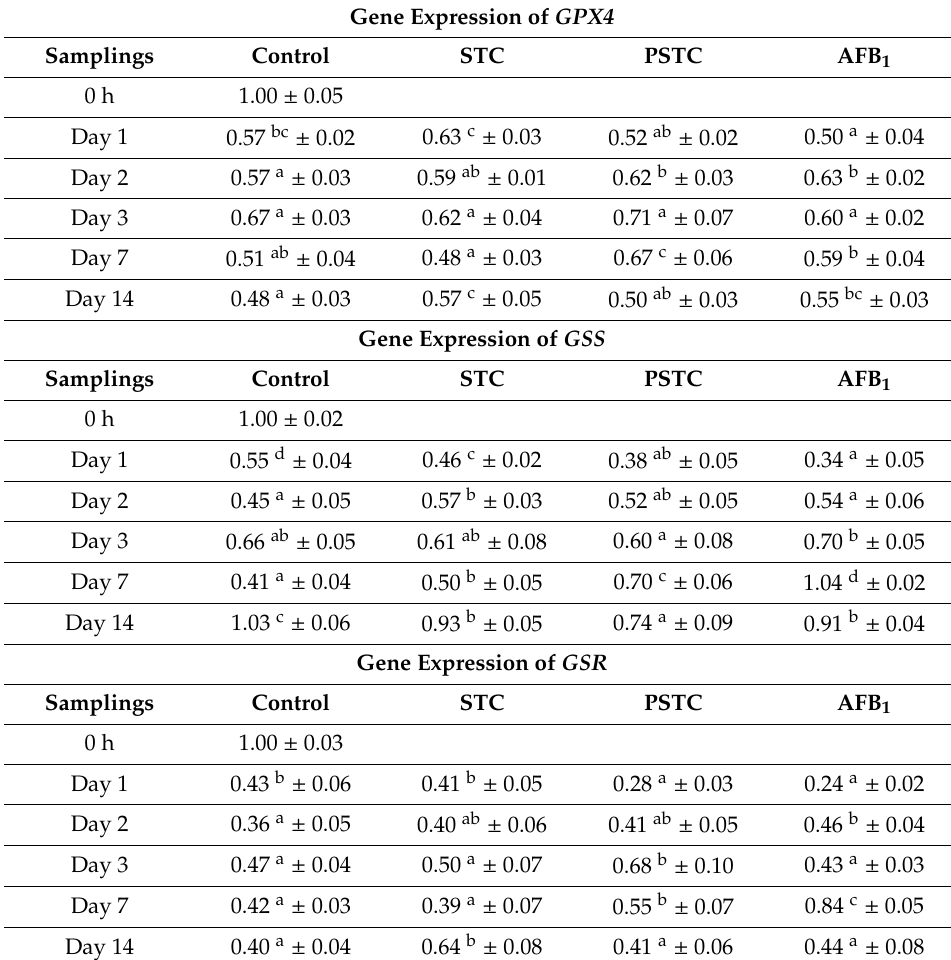
Table 6. E ff ect of sterigmatocystin and aflatoxin on relative gene expression of glutathione peroxidase 4 ( GPX4 ), glutathione synthetase ( GSS ) and glutathione reductase ( GSR ) in the liver of broiler chickens (mean ± SD; n = 6, in a pool, equal amount of